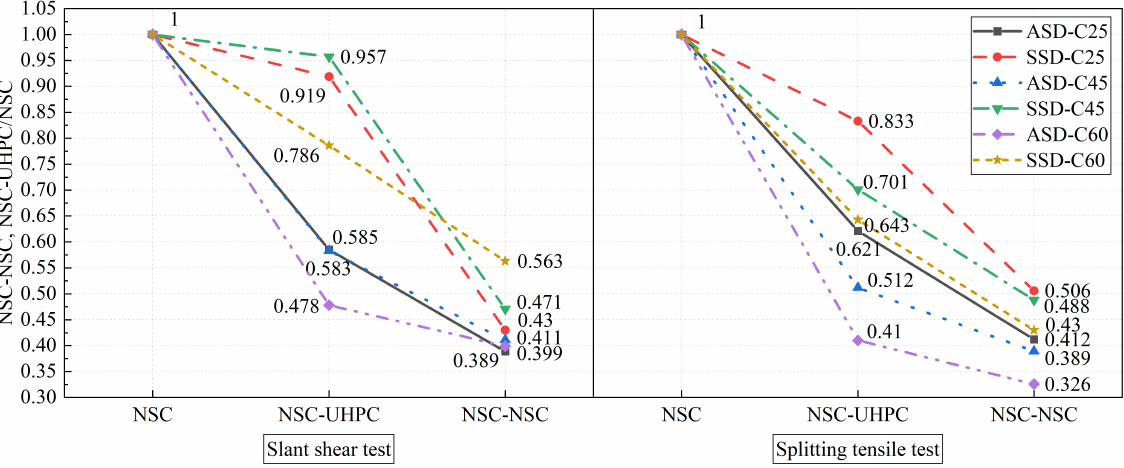
Figure 7. Effects of the repair strength on the interfacial bond